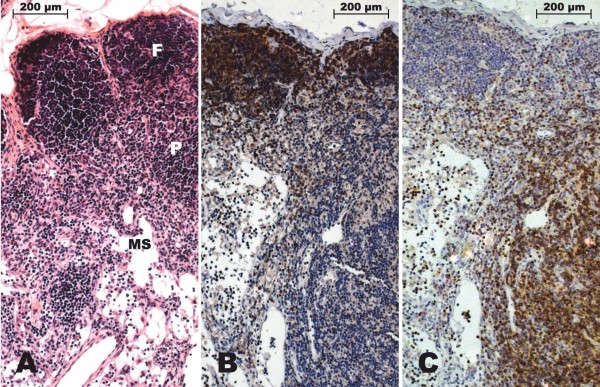
Physiological structure of a lymph node from a rabbit of the control group without surgery. A. Routine histological staining allows the recognition of different compartments: follicles (F), paracortical zone (P) and medullary sinuses (MS), (H&E, ×100). B. CD79α-immunostaining detects mature B-cells, predominantly located in the follicles, and plasma cells in the paracortical zone (IHC method, ×100). C. CD3-immunostaining detects T-cells, predominantly located in the paracortical zone (IHC method, ×100).